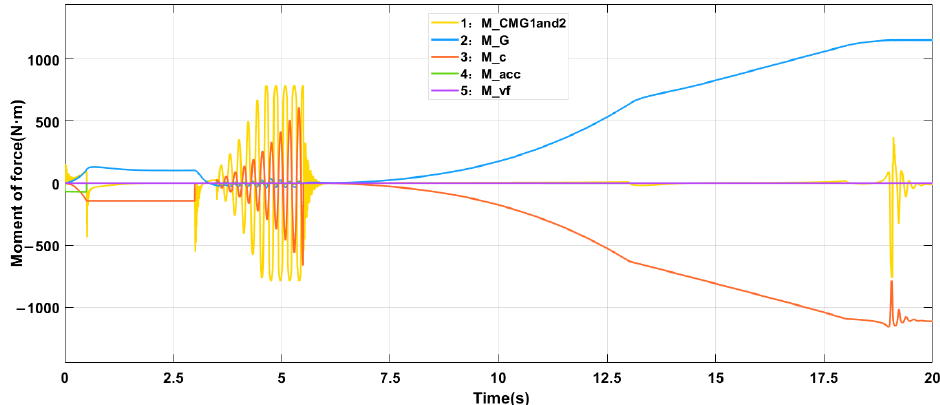
Figure 18. Simulation results: Various types of moments generated during the self-balancing of the dynamically moving vehicle body.